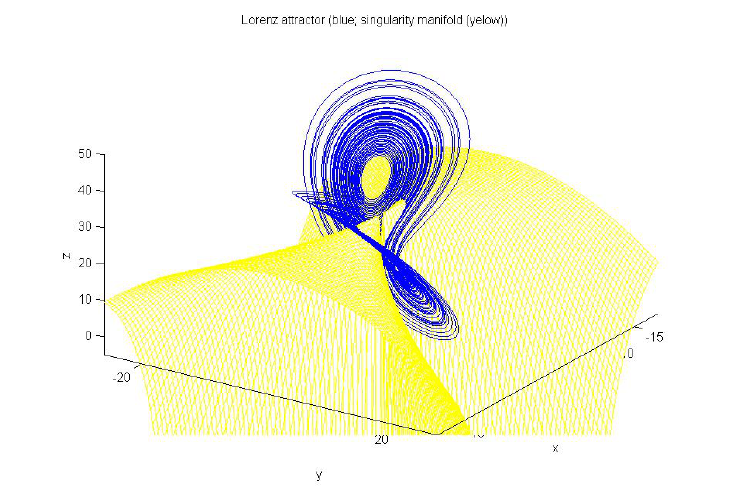
z is selected as output. O (yelow) when